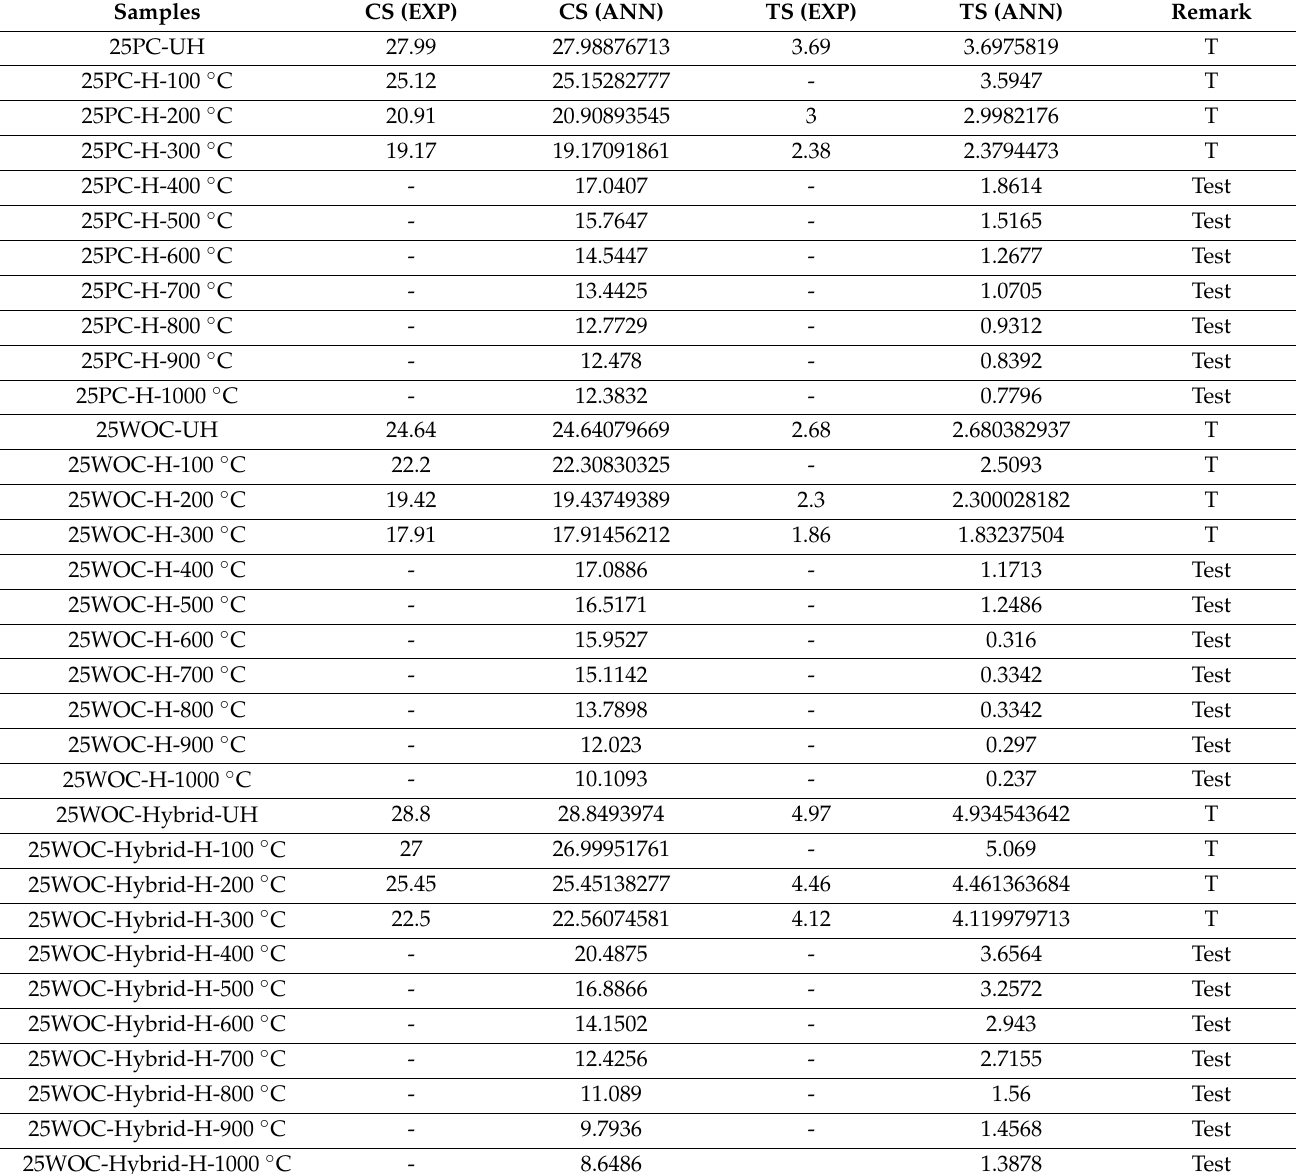
Table 9. Experimental data/results and input and output parameters of PC